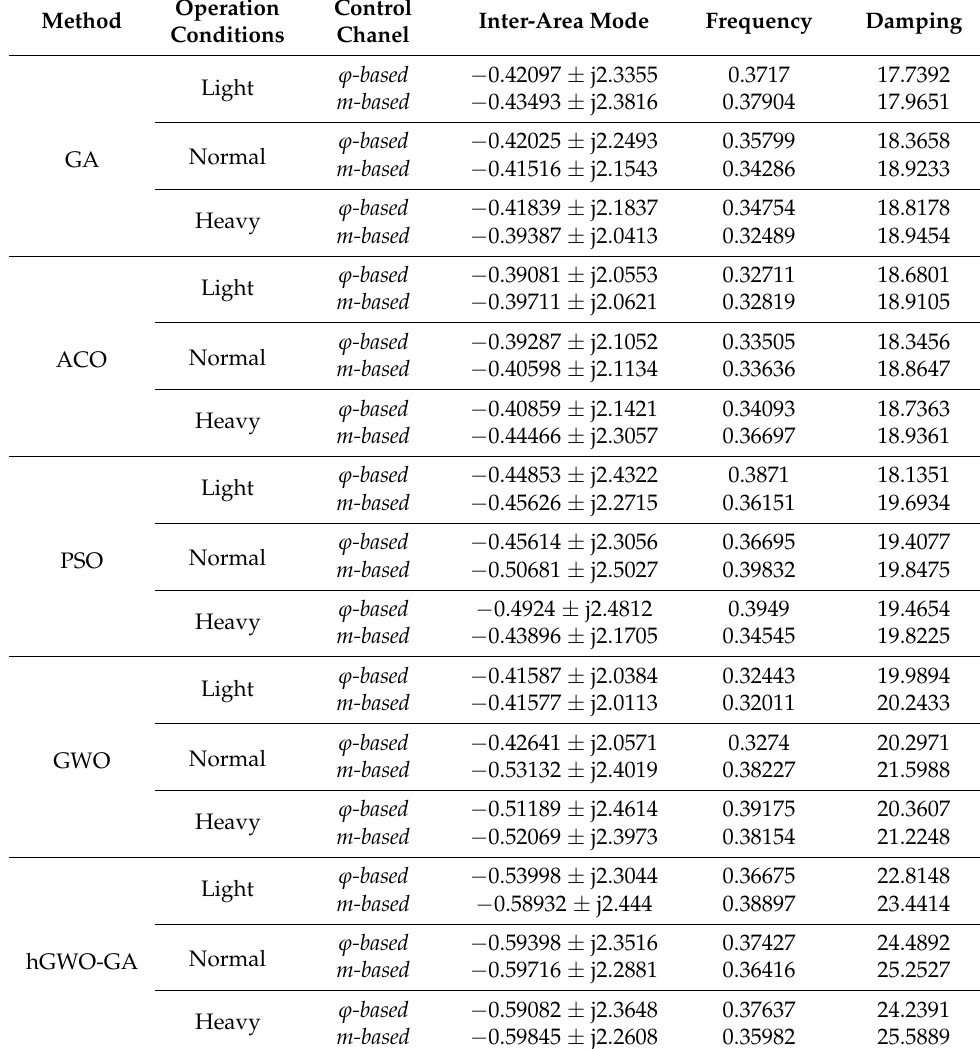
Table 9. Inter-area mode for the closed-loop system in robust design ( F 2 and F